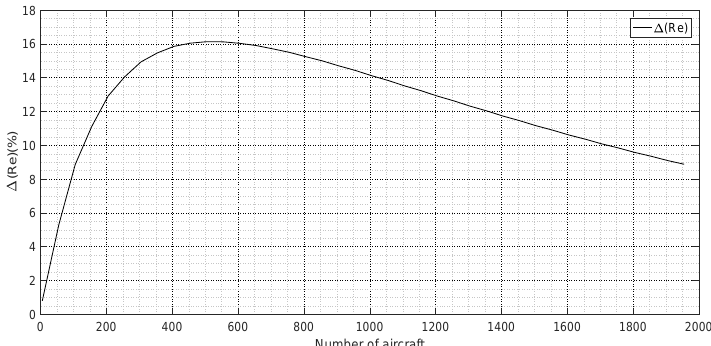
Figure 7. Difference of reply efficiency for different modes vs. number of aircraft.